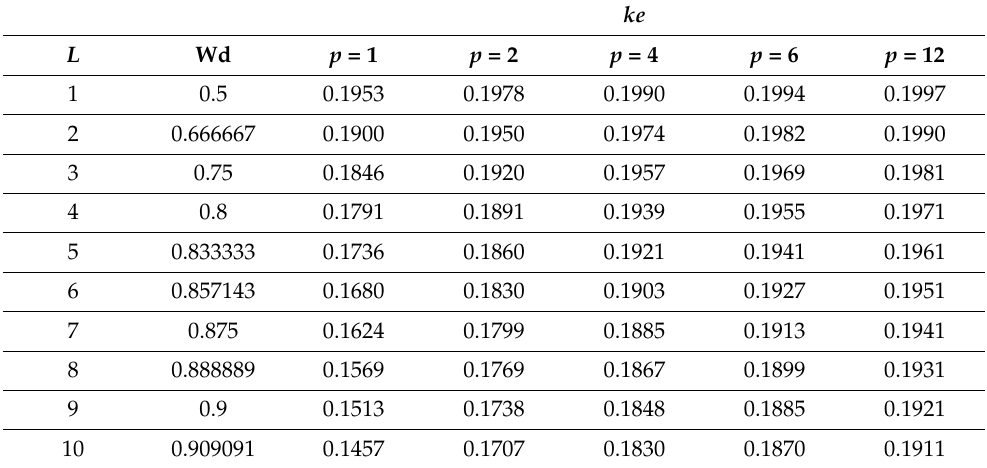
Table 6. The dependence of the equity cost ( ke ) on the leverage level ( L ) of a six-year-old company for advance profit tax payments with frequencies of p = 1, 2, 4, 6 and 12.